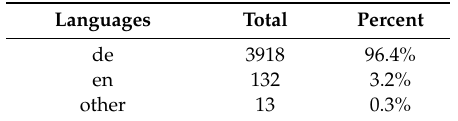
Table A1. Primary languages (at).